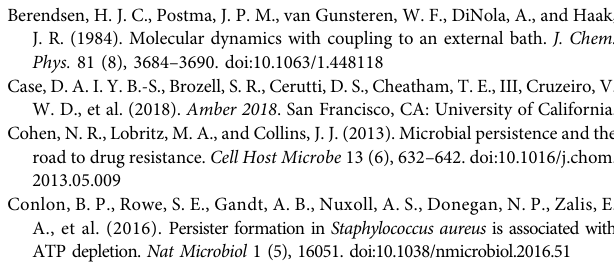
algorithm fi rst, keeping the complex fi xed with a harmonic potential, force constant k (cid:1) 10 kcal/mol Å 2 , followed by 2000 steps of unrestrained minimization), the system was subjected AMBER18. The system was heated at 300 K